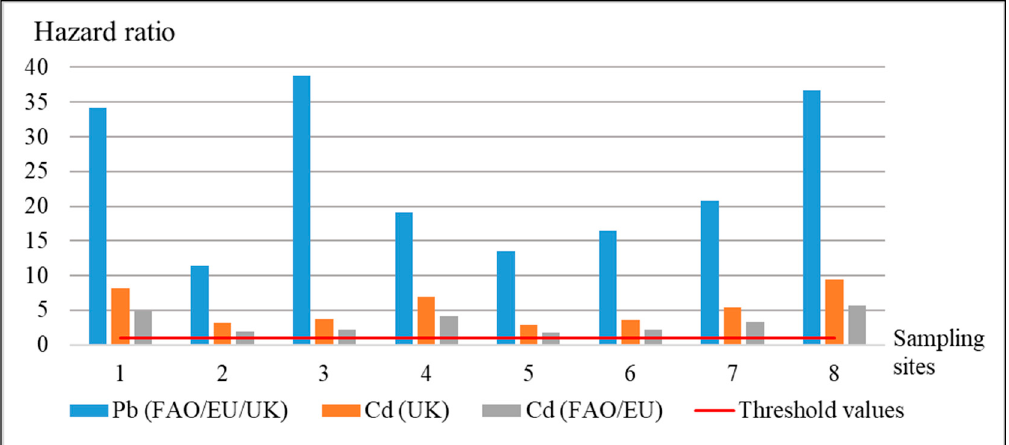
Figure 4. Estimation of the safety of apple consumption for human health by the hazard quotient. The highest values of the hazard quotient by Pb were particular for the sampling points № 1, 3, and 8 (from 34.21 to 38.86); by Cd, for the sampling points 1, 4, and 8 (from 4.2 to 5.68). All sampling points belong to the residential zone. The sampling point № 4,